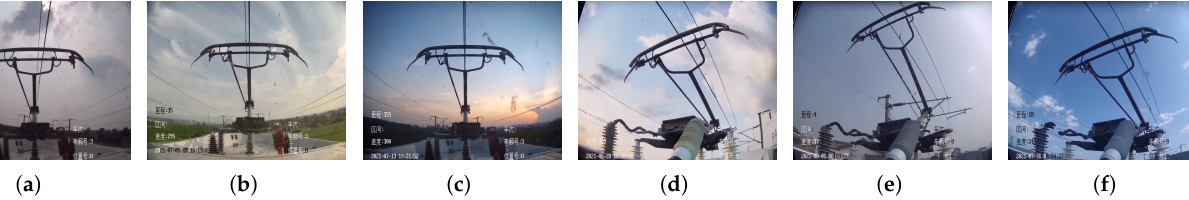
Figure 17. The corresponding HSC in Figure 16 captures the scene without the sun in the frame.